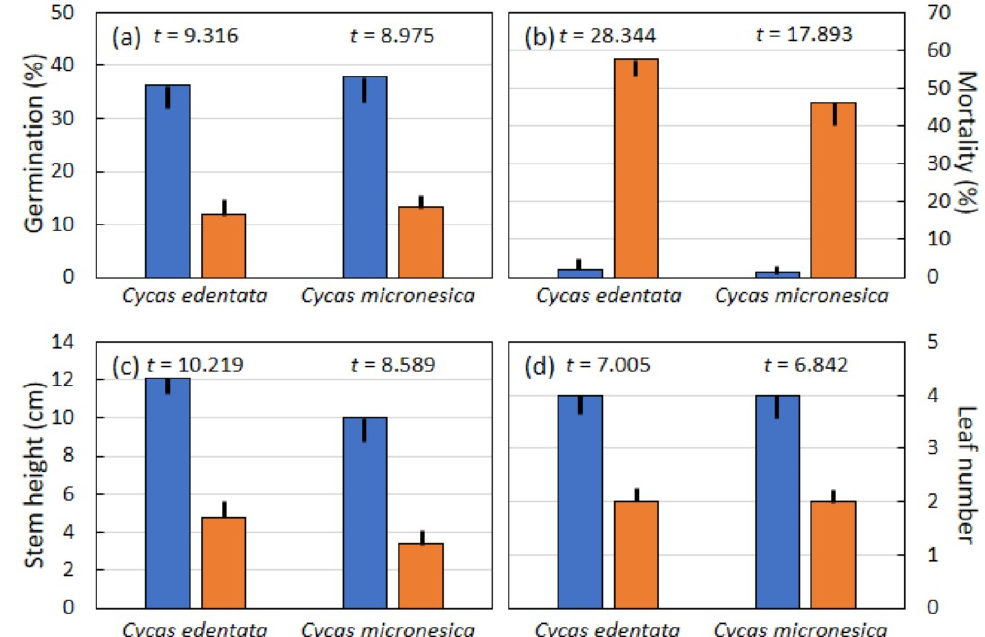
Figure 4. The influence of Aulacaspis yasumatsui infestation on Cycas edentata ( n = 15) and Cycas micronesica ( n = 12) seed integument tissues on germination and seedling responses. ( a ) Germination percentage; ( b ) seedling mortality; ( c ) stem height; ( d ) leaf number per seedling. Mean plus or minus standard error. Blue bars = un-infested seeds, orange bars = infested seeds. Significance was p < 0.001 for every t -test.